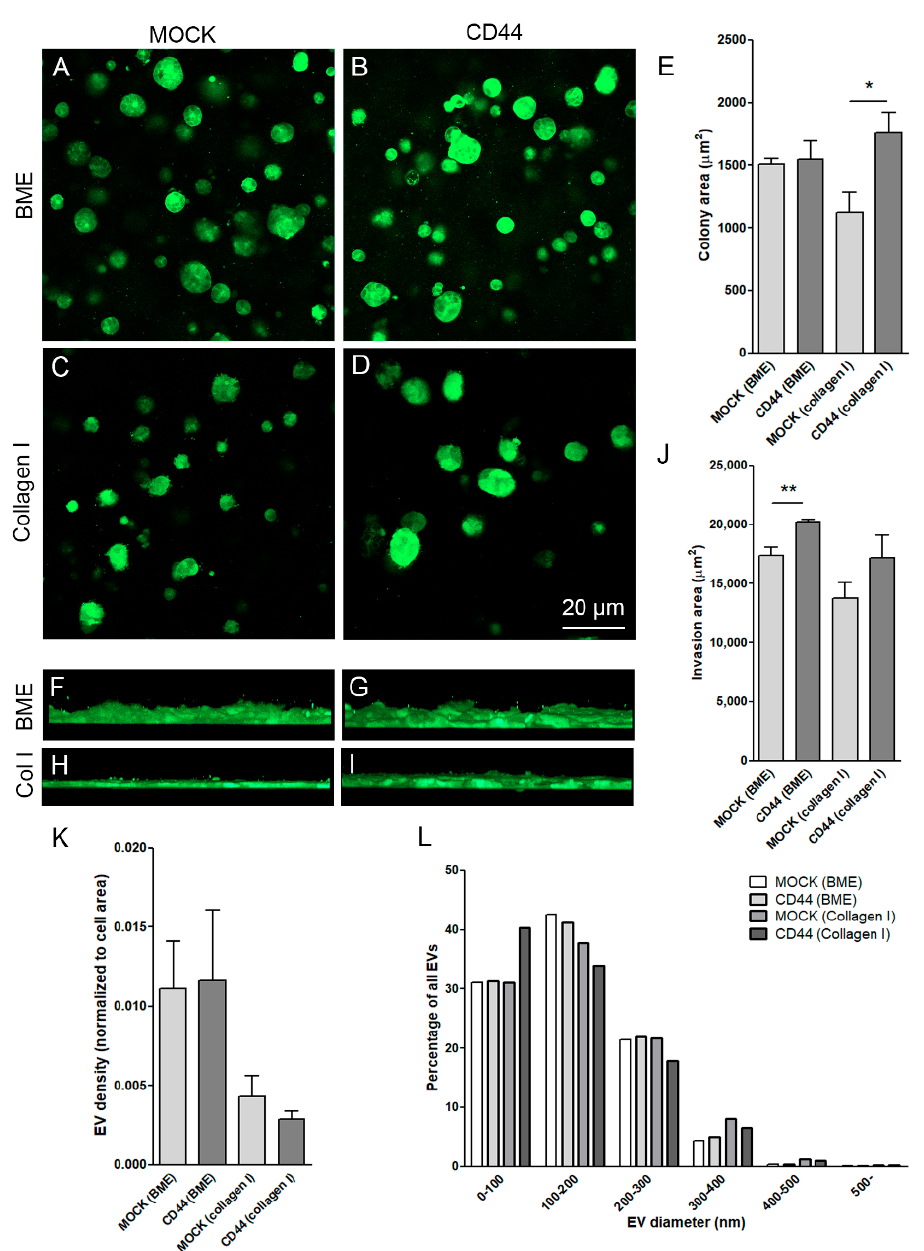
the proportion of Ki-67 positive nuclei (Figure 6G,H). The numbers of Ki-67-positive cells were slightly but significantly decreased in CD44-expressing tumors (Figure 6I).